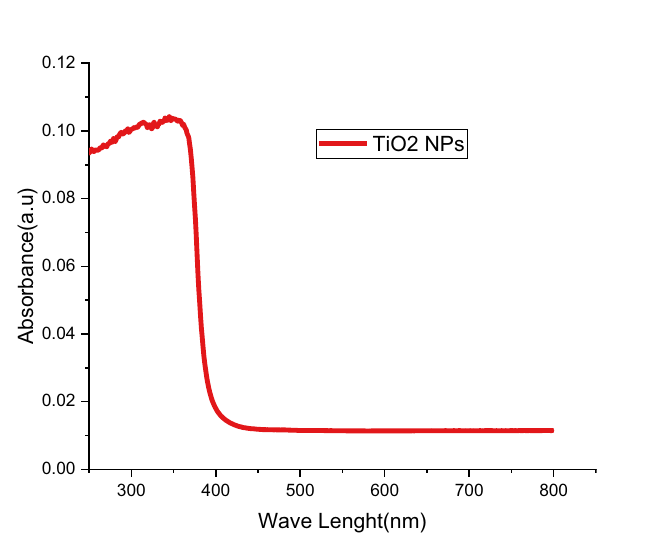
Figure 3. UV-spectra of TiO 2 nanoparticle from Carica papaya shell